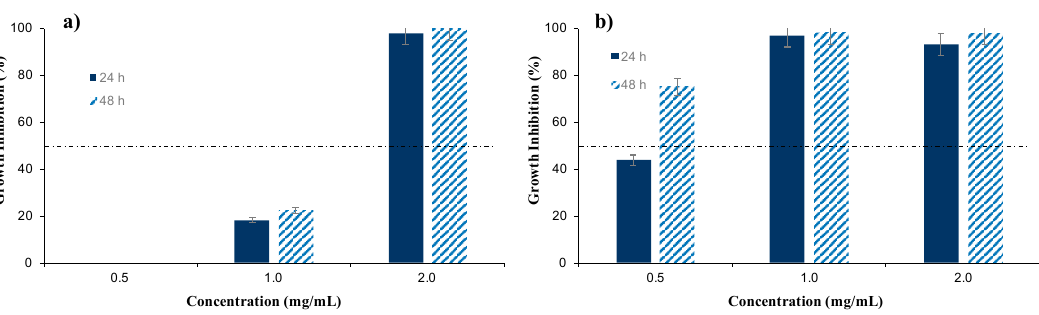
Figure 4. Antimicrobial activity of the biosurfactant extracted from corn steep water (CSW) ( a ) before a filtration stage (NFBS) and ( b ) after a filtration stage (FBS) against E. coli after 24 and 48 h of incubation. The results represent the average of triplicate experiments ± standard deviation.